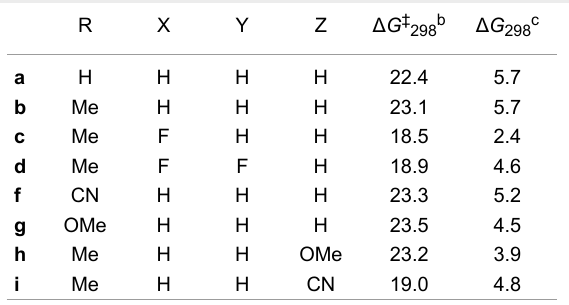
Table 1: Calculated free energy activation and change (kcal/mol) for the cyclization of cis -azopyridine 4 -Z to the nonaromatic product 10 in MeCN (Scheme 3). a